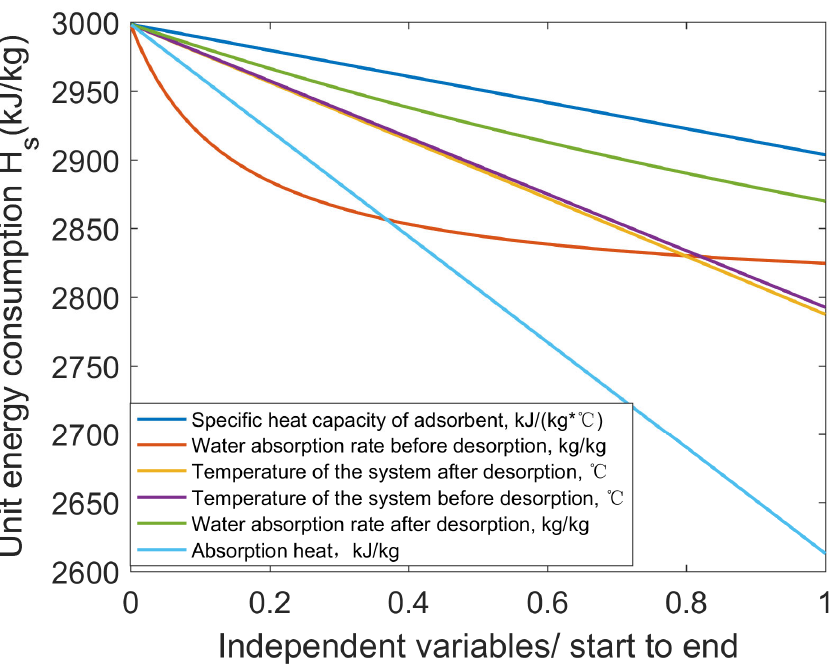
Figure 6. Relationship between energy consumption per unit water and independent variables of adsorption and desorption water harvesting.